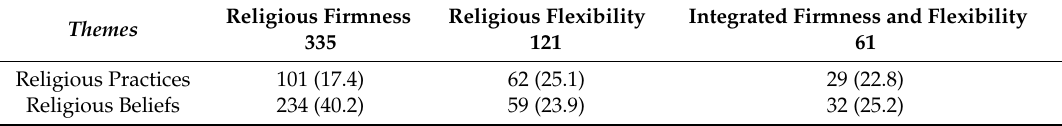
Table 2. Frequencies and Percentages: Firmness and Flexibility in Religious Practices and